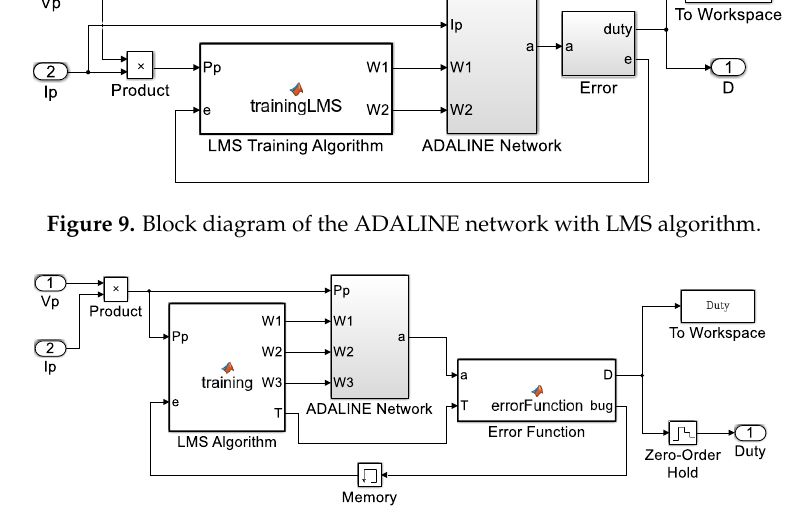
Figure 10. Block diagram of the ADALINE network with Iterative LMS algorithm.